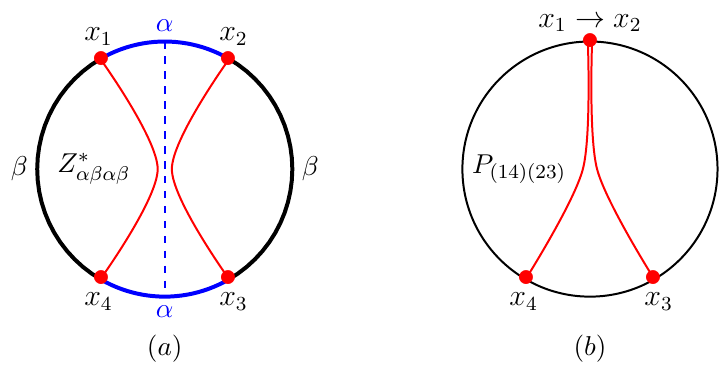
Figure 3 . (a) Partition function Z (cid:3) . It is drawn a dual FK cluster (dashed line) leading to (cid:11)(cid:12)(cid:11)(cid:12) a vertical crossing. These cluster con(cid:12)gurations are dual to the ones contributing to P . In (14)(23) particular it is not possible to connect x 1 with x 3 or x 2 with x 4 without crossing the dual dashed cluster. (b) The limit x 1 x 2 in the function P produces con(cid:12)gurations where two distinct (14)(23) ! FK clusters meet at x 2 . Field theoretically this is interpreted as the insertion of the (cid:12)eld (cid:30) 1 ; 5 at the boundary point x 2